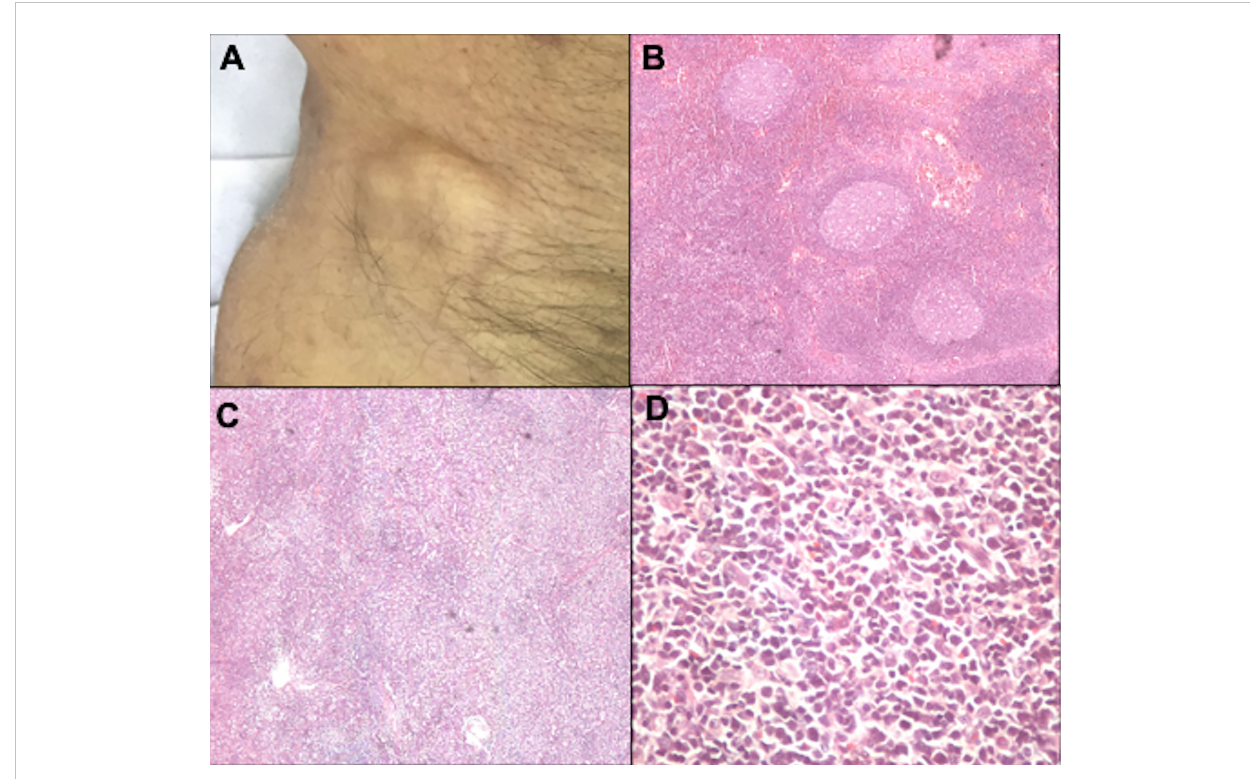
FIGURE 12 Lymph node evaluation. Inguinal lymph node enlargement (A) . Dermatopathic lymphadenopathy with the presence of germinal centers, hematoxylin-eosin at 20x magni fi cation (B) . Lymph node involvement by lymphoma, with architectural alteration, hematoxylin-eosin at 20x magni fi cation (C) . Pleomorphic lymphoid cells, hematoxylin-eosin at 200x magni fi cation (D)